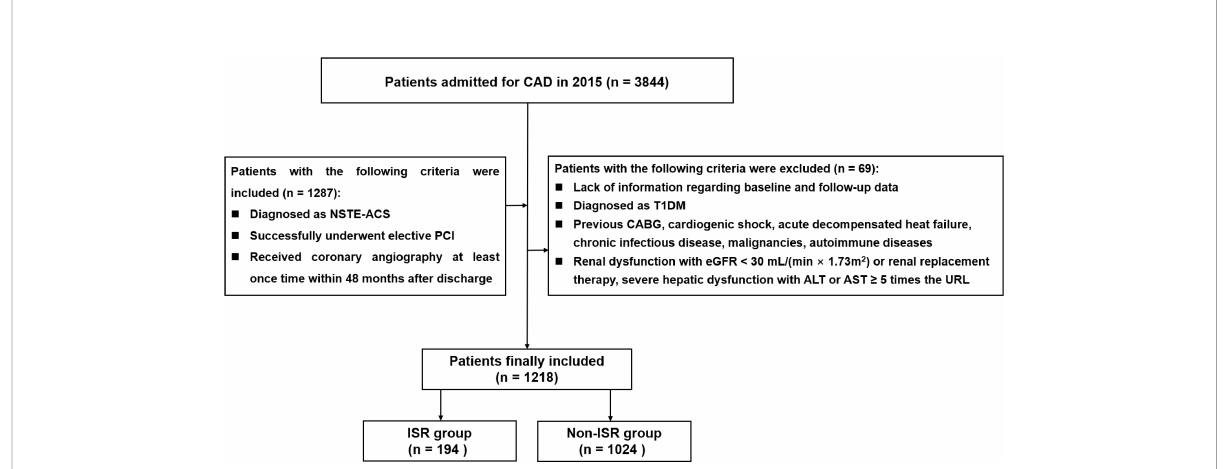
FIGURE 1 Flow diagram for the enrollment of study population. CAD coronary artery disease, NSTE-ACS non-ST-segment elevation acute coronary syndrome, PCI percutaneous coronary intervention, T1DM Type 1 Diabetes mellitus, CABG coronary artery bypass grafting, eGFR estimated glomerular fi ltration rate, ALT alanine transaminase, AST aspartate transaminase, URL upper reference limit, ISR in-stent